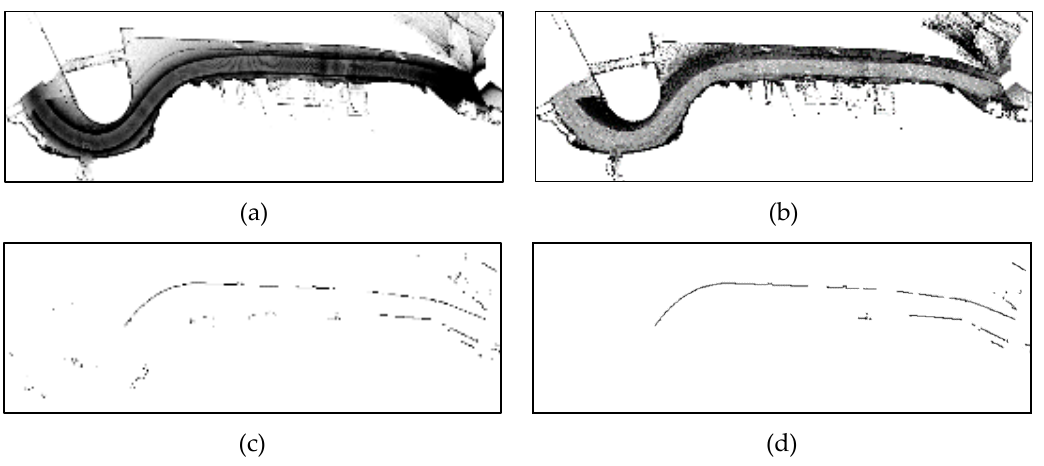
Figure 5. Results obtained in every step of the proposed method to detect curbs for slice 1 of dataset 1: ( a , b ) are the density and the nDSM image, and ( c , d ) are the results of the thresholding and the morphological operations, respectively.